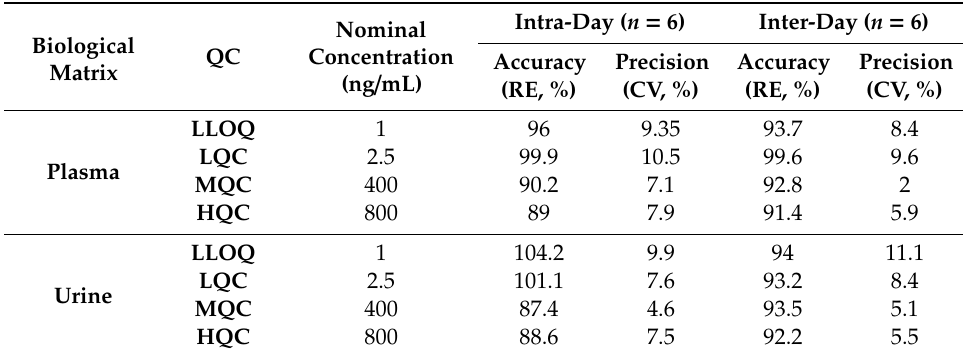
Table 1. Accuracy and precision data of LC-MS / MS method for the quantification of GMC1 in